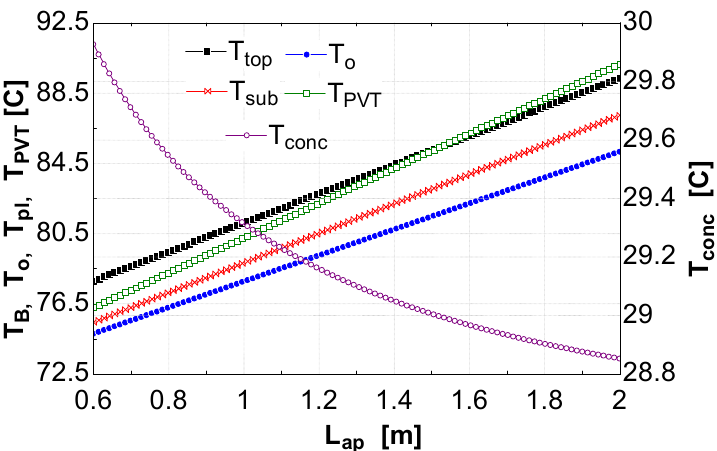
Figure 13. CPVT Temperatures vs. aperture